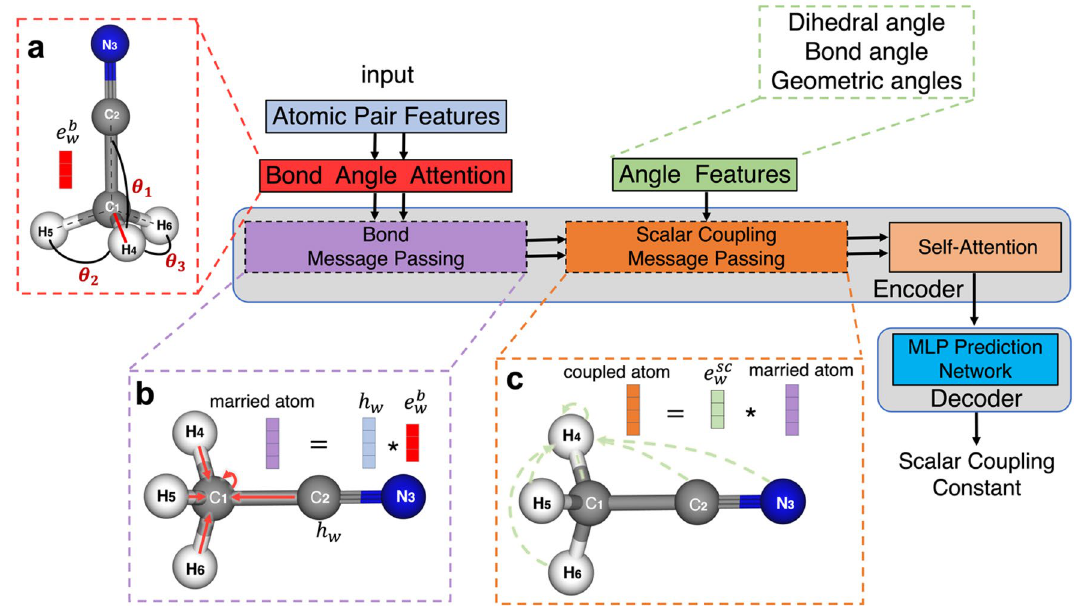
Figure 2. Overview of graph angle-attention neural network (GAANN). ( a ) (left) Bond Angle Attention. The red box corresponds to the bond angle attention in the encoder flow chart. ( b ) (center) Bond Message Passing. The purple box corresponds to the bond message passing layer. The neighbor’s bonds e b w depicted in the red feature vector are aggregated to update the centered atom C 1 into the ‘married’ atom. ( c ) (right) Scalar Coupling Message Passing. The orange box corresponds to the scalar coupling message passing layer. The neighbor’s scalar coupling edges e sc w depicted in the green feature vector are aggregated to update the centered atom H 4 into the ‘coupled’ atom. Next, the self-attention layer is used to extract the features of the ‘coupled’ atom in the yellow box. Finally, the purple box corresponding to the MLP is used to decode and predict the